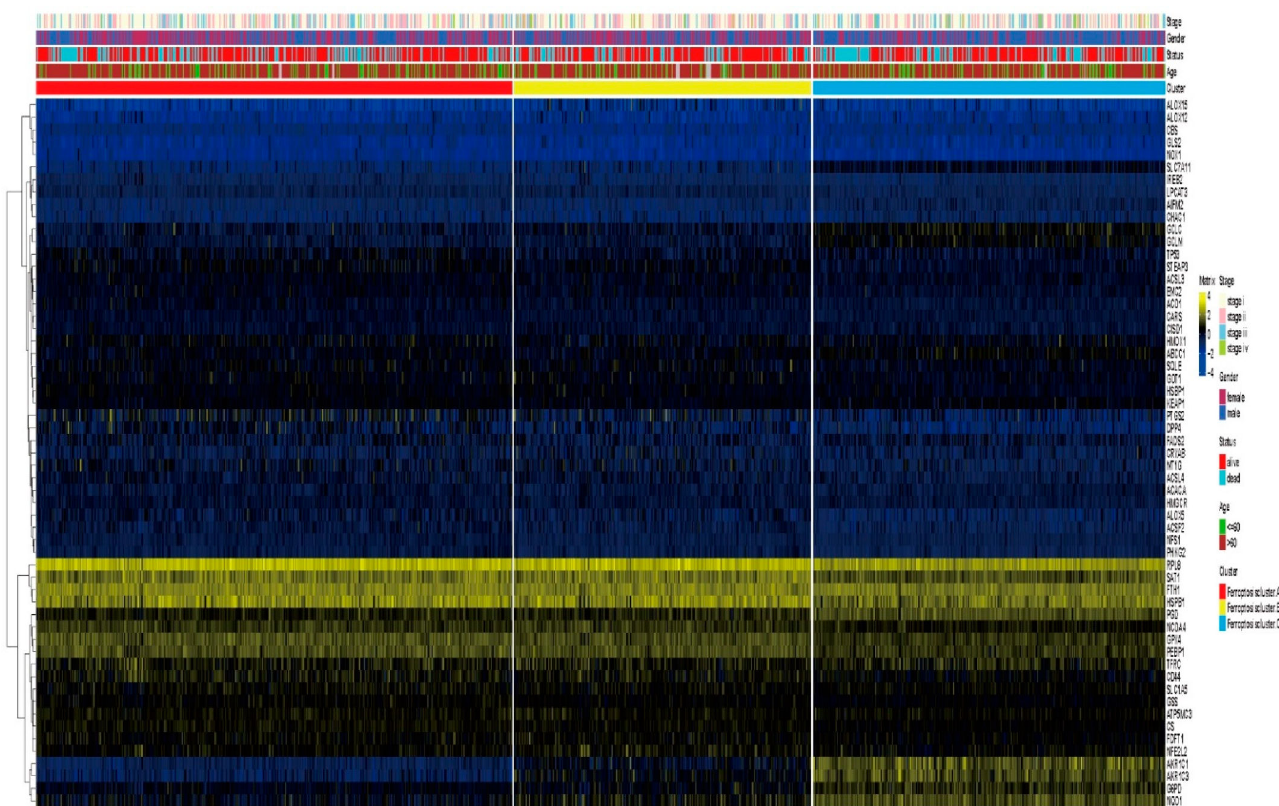
Figure 4. Unsupervised clustering of ferroptosis-related genes in the three ferroptosis patterns. The ferroptosis pattern, gender, tumor stage, age and survival status are used as patient annotations. Blue indicates low expression regulatory factors, yellow indicates high